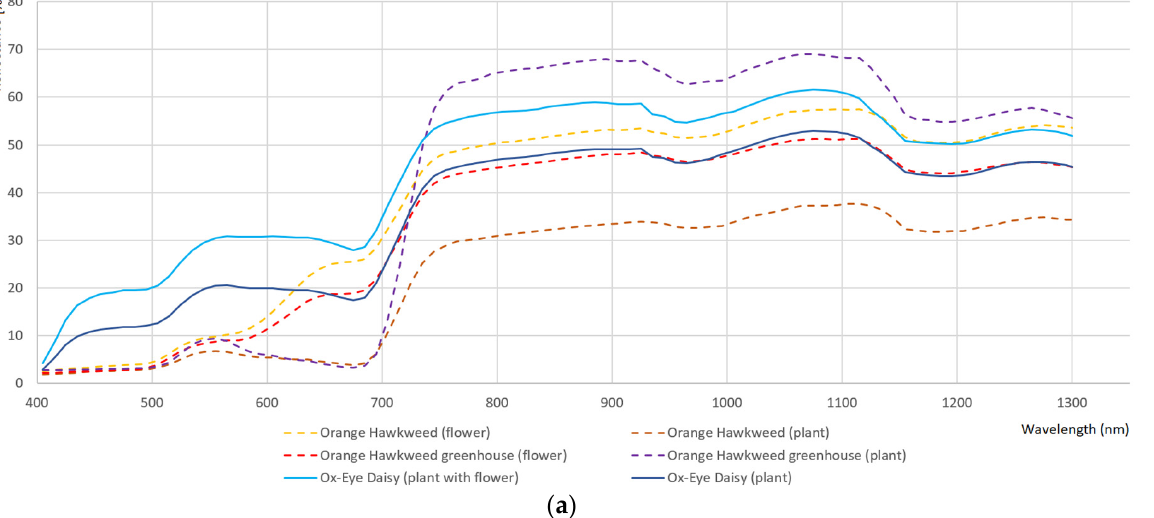
( b ) Figure 5. Averaged spectral profiles collected by the spectroradiometer with lens after pre-processing. ( a ) Profiles of the Orange Hawkweed and Ox-eye Daisy; ( b ) Profiles of the weeds versus other co-occurring plants. The important variables (wavelength regions) were highlighted. The confusion matrix of the RF classification of the first survey data is presented in Table 3. The overall accuracy of the classification is 0.6968 with a Kappa value of 0.6651, representing a substantial strength of agreement. Table 3 shows the misclassifications be- tween the Ox-eye daisy plants only and Ox-eye daisy flowers, and this is due to the sam- pling with lens. The other important output, “ variable importance measures ”, of the Random Forest classification provided an indicative insight into the wavelengths where the dis- criminability of the weed species is maximized. The most useful top 20 wavelengths for spectral discrimination were found to include the bands: 400–420, 440–480, 510–550, 570– 580, 640–690, 710–750 and 1300 nm, as shown in Figure 5b. Table 3. Confusion matrix of the RF classification results of using the spectral profiles collected by the spectroradiometer with lens. (ADB—Alpine daisy bush; AGR—Alpine grevillea; ASP—Alpine shaggy-pea; BOS—Leafy bossiaea; BSE—Black sally; CAS—Sticky cassinia; KGA—Kangaroo grass; OHff—Orange hawkweed in field with flower; OHfp—Orange hawkweed in field with plant; OHgp—Orange hawkweed in greenhouse with flower; OHgp—Orange hawkweed in greenhouse with plant; OXf—Ox-eye daisy with flower; OXp—Ox-eye daisy with plant; PDf— Alpine everlasting with flower; PDp—Alpine everlasting with plant; SGR—Snow grass.; PA— Producer’s Accuracy; and UA—User’s Accuracy).